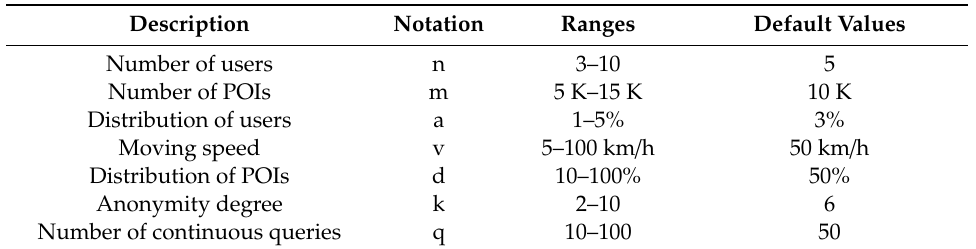
Table 4. Parameters and their values.